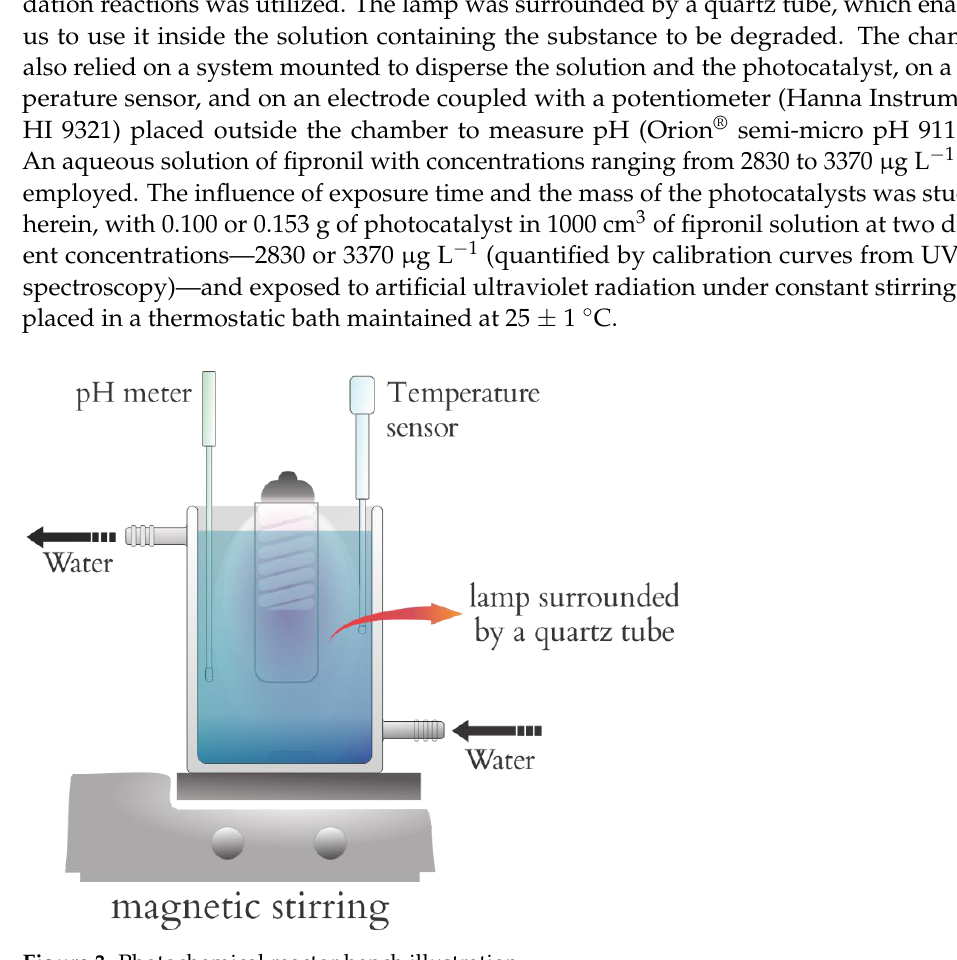
Figure 3. Photochemical reactor bench